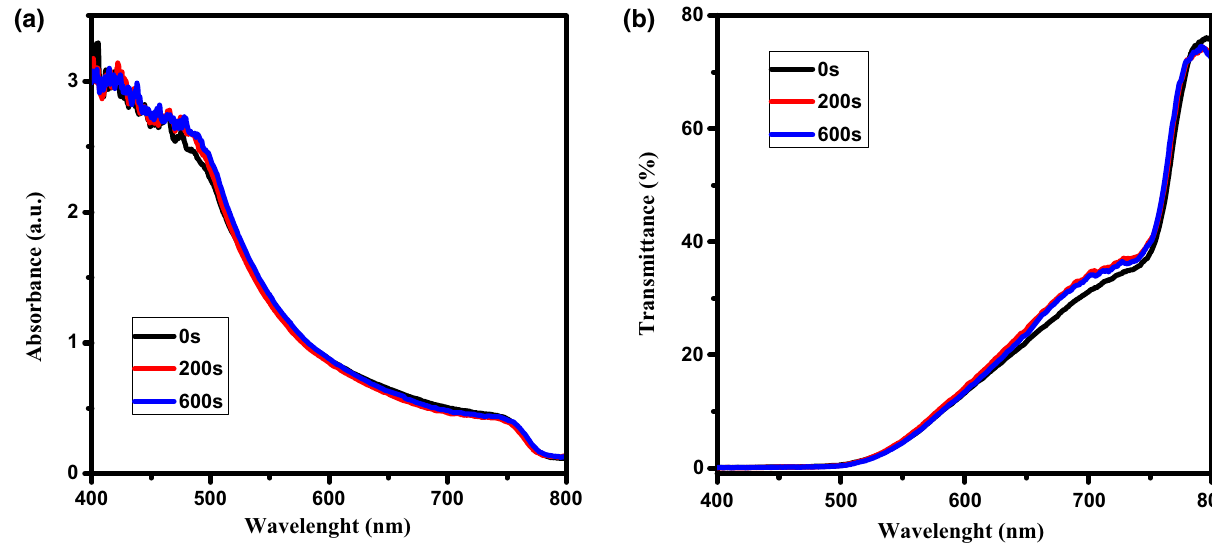
Fig. 7 a Absorption and b transmittance spectra of perovskite films annealed at 90 °C and aged at different